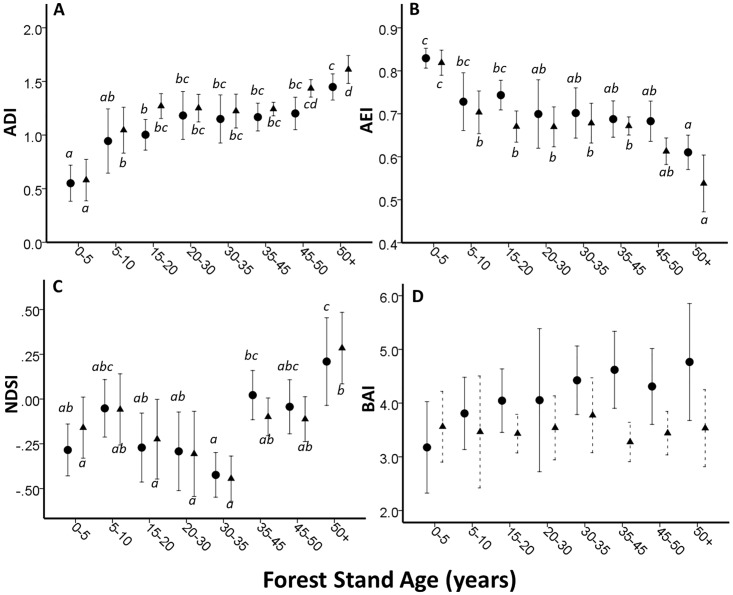
Relationships between acoustic indices with coniferous forest stand age (N = 65) from each year (dots = 2014 data; triangles = 2015 data).Letters represent mean groupings from the Gabriel post-hoc test (p<0.05). A) Mean ADI (+/-2 SE). 2014, F7,57 = 6.896, p<0.001; 2015, F7,57 = 18.772, p<0.001. B) Mean AEI (+/-2 SE) 2014, F7,57 = 5.417, p<0.001; 2015, F7,57 = 14.359, p<0.001. C) Mean NDSI (+/-2 SE) 2014, F7,57 = 5.827, p<0.001 (abc); 2015: F7,57 = 5.010, p<0.001. D) Mean BAI—there were no significant differences between age-groups but the plotted means indicate that in 2014 the mean BAI values were higher in older stands.